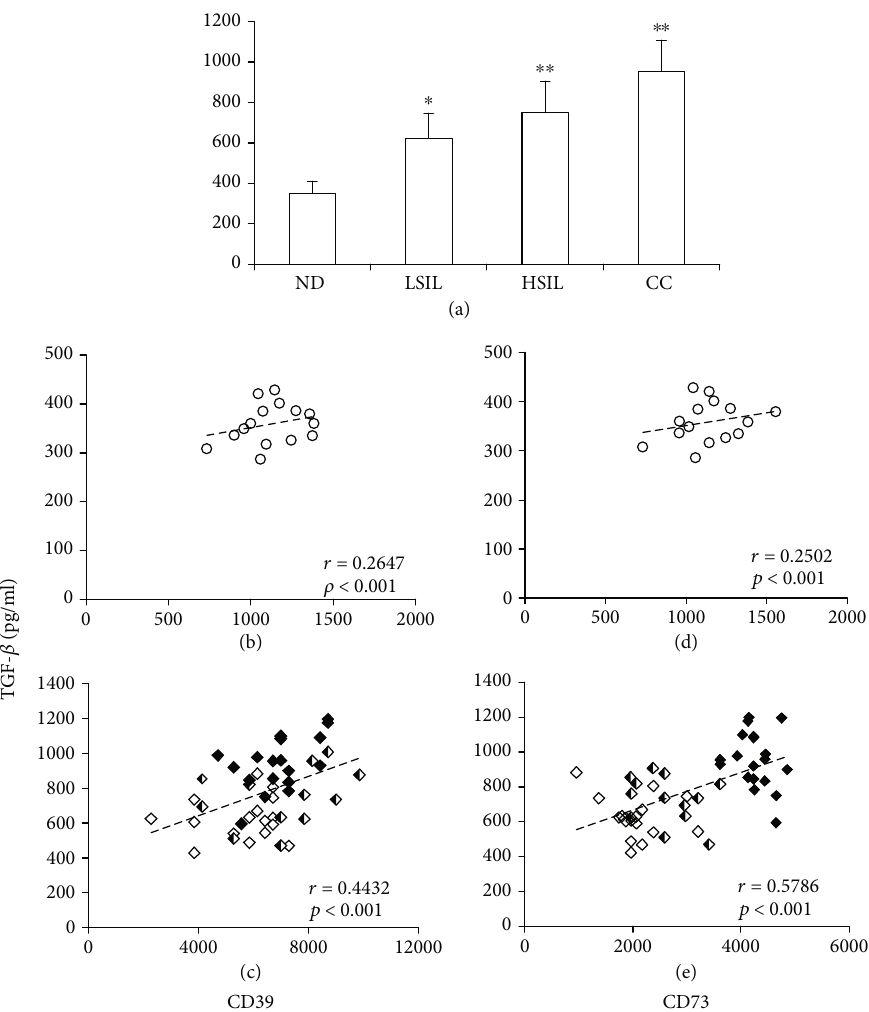
Figure 5: TGF- β concentrations in PFP samples from NDs and patients with LSILs, HSILs, or CC and their correlations with the concentrations of CD39 and CD73. (a) The TGF- β 1 content is shown in PFP samples taken from NDs and patients with LSILs, HSILs, or CC. The data are representative of three independent experiments, and the means ± SEMs are shown. ∗ p < 0 : 05 , ∗∗ p < 0 : 001 for the concentration of TGF- β 1 in a patient group relative to the ND group. The correlations ( r ) between the levels of TGF- β 1 and CD39 or CD73 in the PFP of NDs were r = 0 : 2647 ( p < 0 : 001 ) (b) and r = 0 : 2502 ( p < 0 : 001 ) (d), respectively. For patients with LSILs, HSILs, or CC, the correlations were r = 0 : 4432 ( p < 0 : 001 ) (c) and r = 0 : 5786 ( p < 0 : 001 ) (e), respectively. The coordinates of the TGF- β 1 concentration with the CD39 or CD73 concentration are indicated by white circles in the ND group, white diamonds in the LSIL group, white and black diamonds in the HSIL group, and black diamonds in the CC